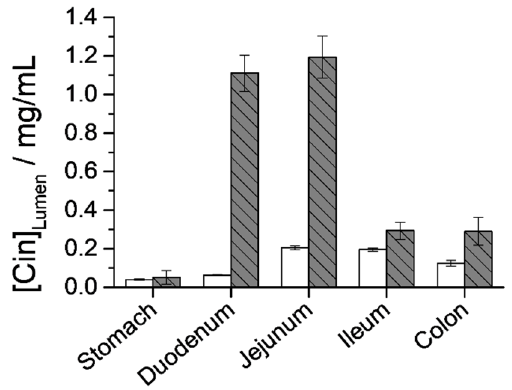
Figure 13. Cinnamaldehyde ( Cin ) concentrations in the detailed GIT sections after 2 h from an oral administration of a dose of 13,6 mg Cin in the different formulations: free (white bars) or encapsulated into the M41-Cin-L microdevice (gray stripped bars). The subjects’ number was n = 3, provided data represent the data average, and error bars represent the standard deviation.